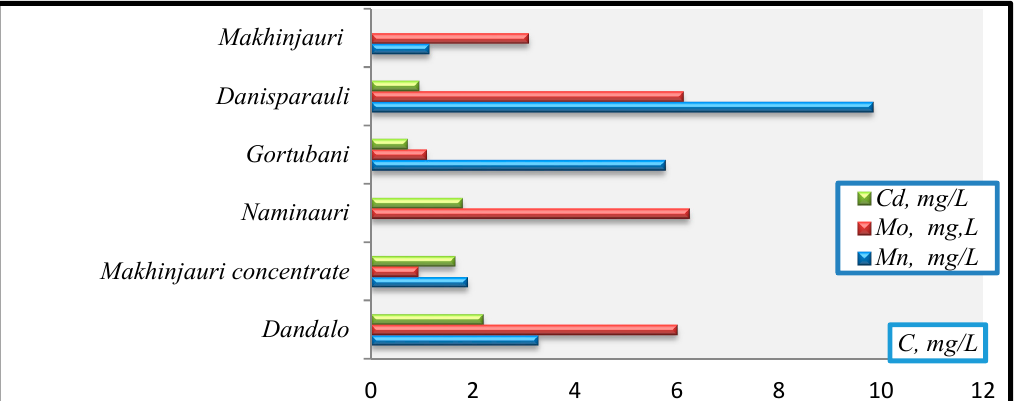
Figure 11. The content of Na, Ba and Ti in the mineral waters.